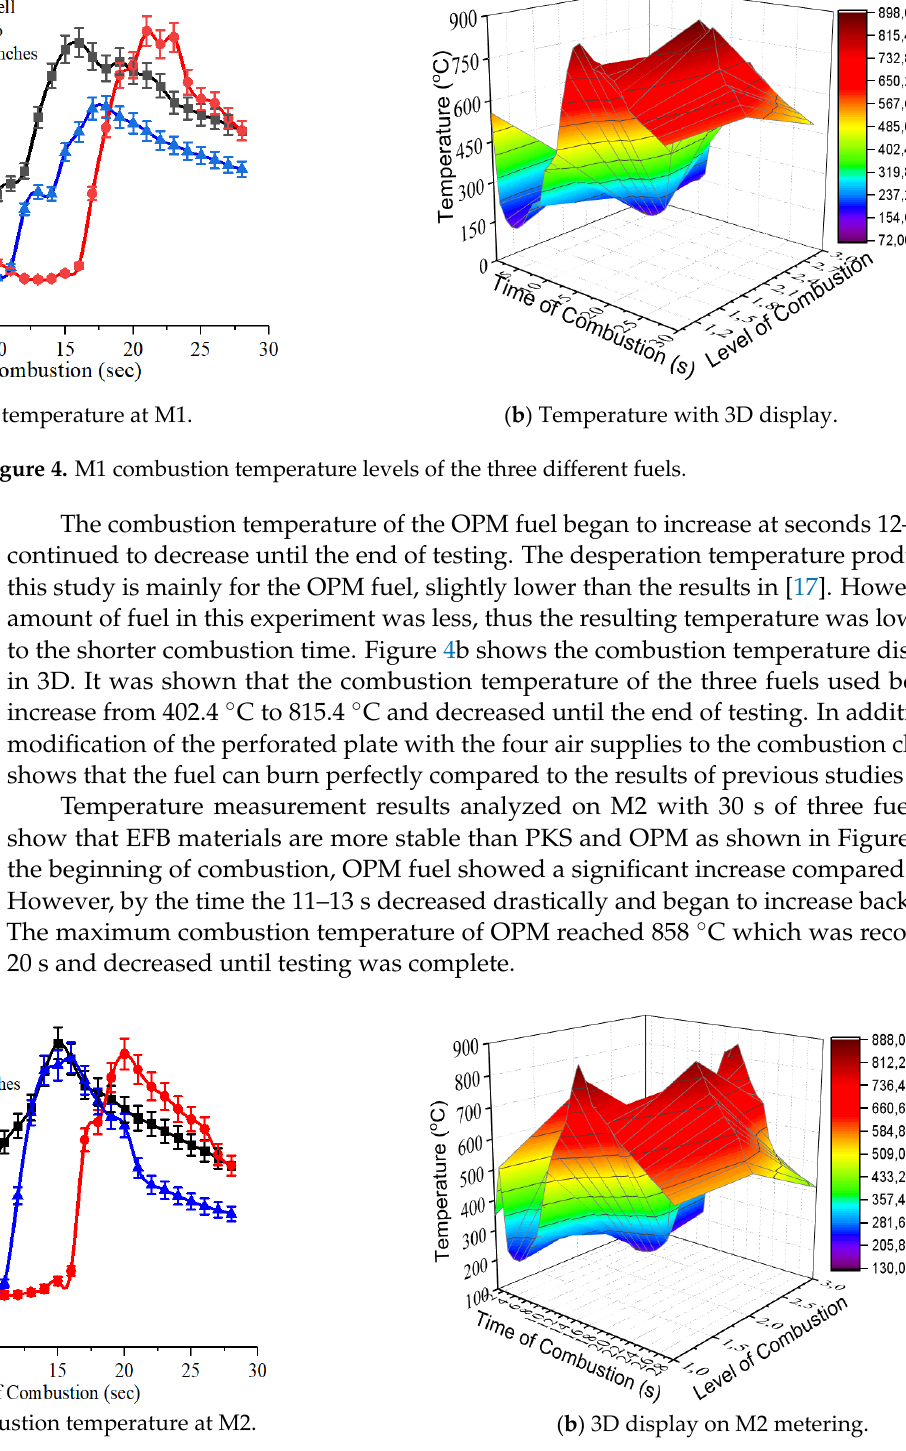
Figure 5. Combustion Temperature Level of M2 at Different Time and Fuel.